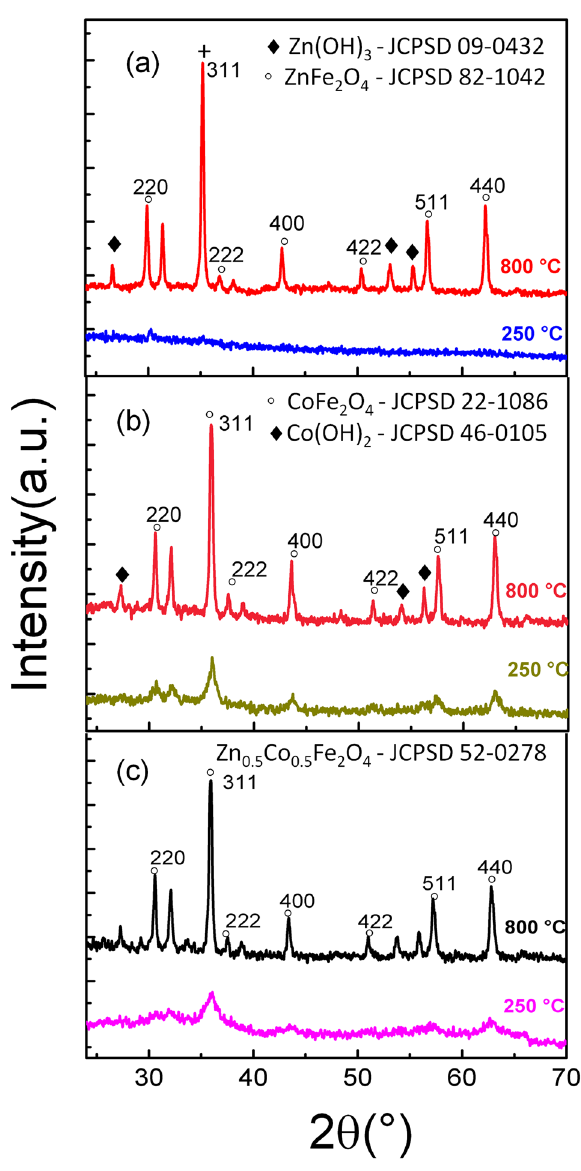
Fig. 4 X-ray diffraction diffractograms for the ZnFe 2 O 4 ( a ), CoFe 2 O 4 ( b ) and Zn 0.5 Co 0.5 Fe 2 O 4 ( c ) NPs calcinated at 250 and 800